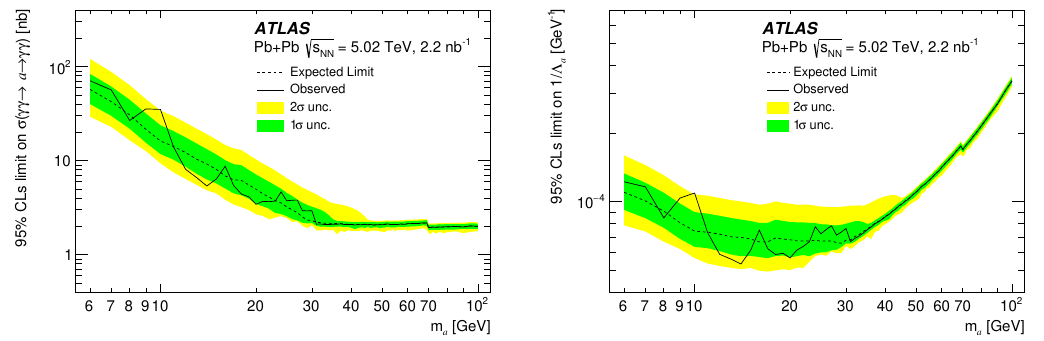
Figure 9 . The 95% CL upper limit on the ALP cross section σ γγ → a → γγ (left) and ALP coupling 1 / Λ a (right) for the γγ → a → γγ process as a function of ALP mass m a . The observed upper limit is shown as a solid black line and the expected upper limit is shown by the dashed black line with its ± 1 and ± 2 standard deviation bands. The discontinuity at m a = 70 GeV is caused by the increase of the mass-bin width which brings an increase in signal